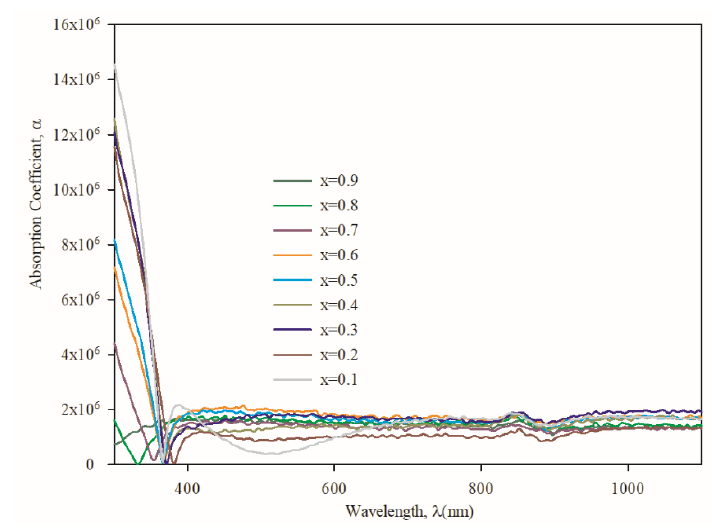
Figure 7. Absorption coefficient of Zn 1-x Mg x S thin films (0.1 ≤ x ≤ 0.9).